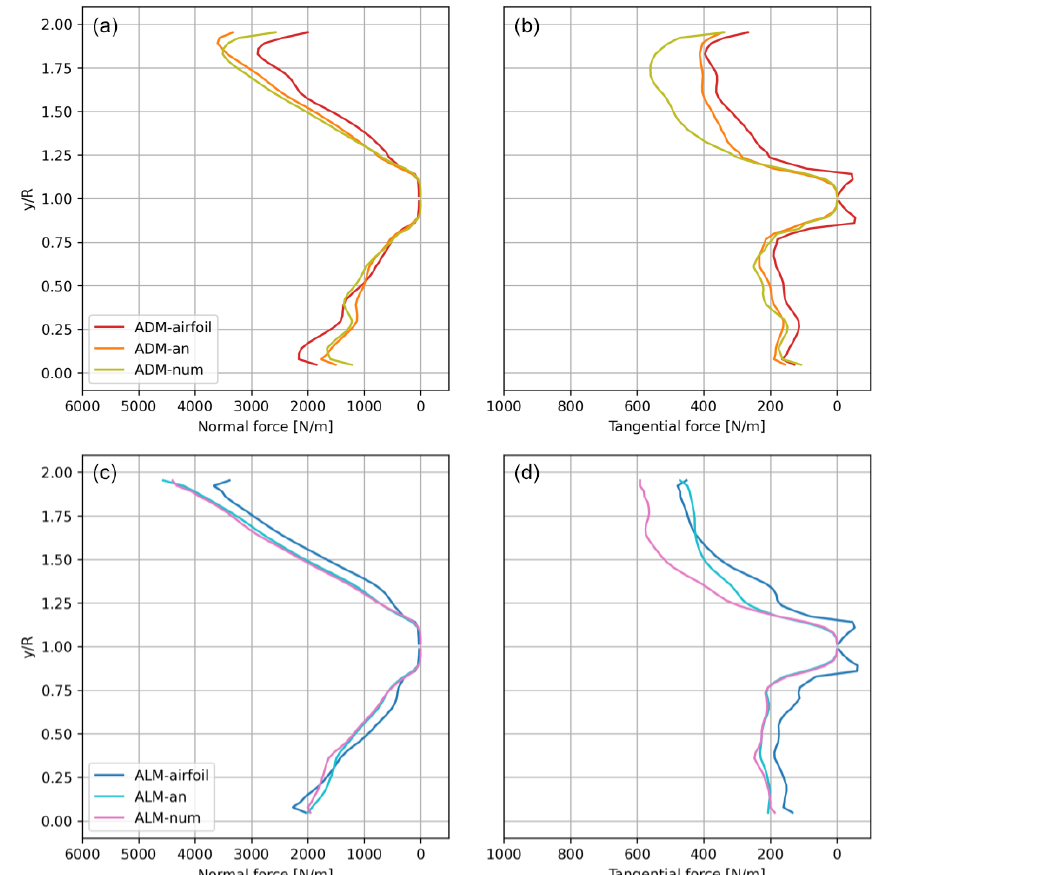
Figure 11. Model comparison for two turbines in an ABL under average velocity inflow conditions of U hub = 8ms − 1 : average (a, c) normal and (b, d) tangential force distributions for WT2 for the azimuthal angles 90 ± 10 ( y/R from 0 to 1) and the azimuthal angles 270 ± 10 ( y/R from 1 to